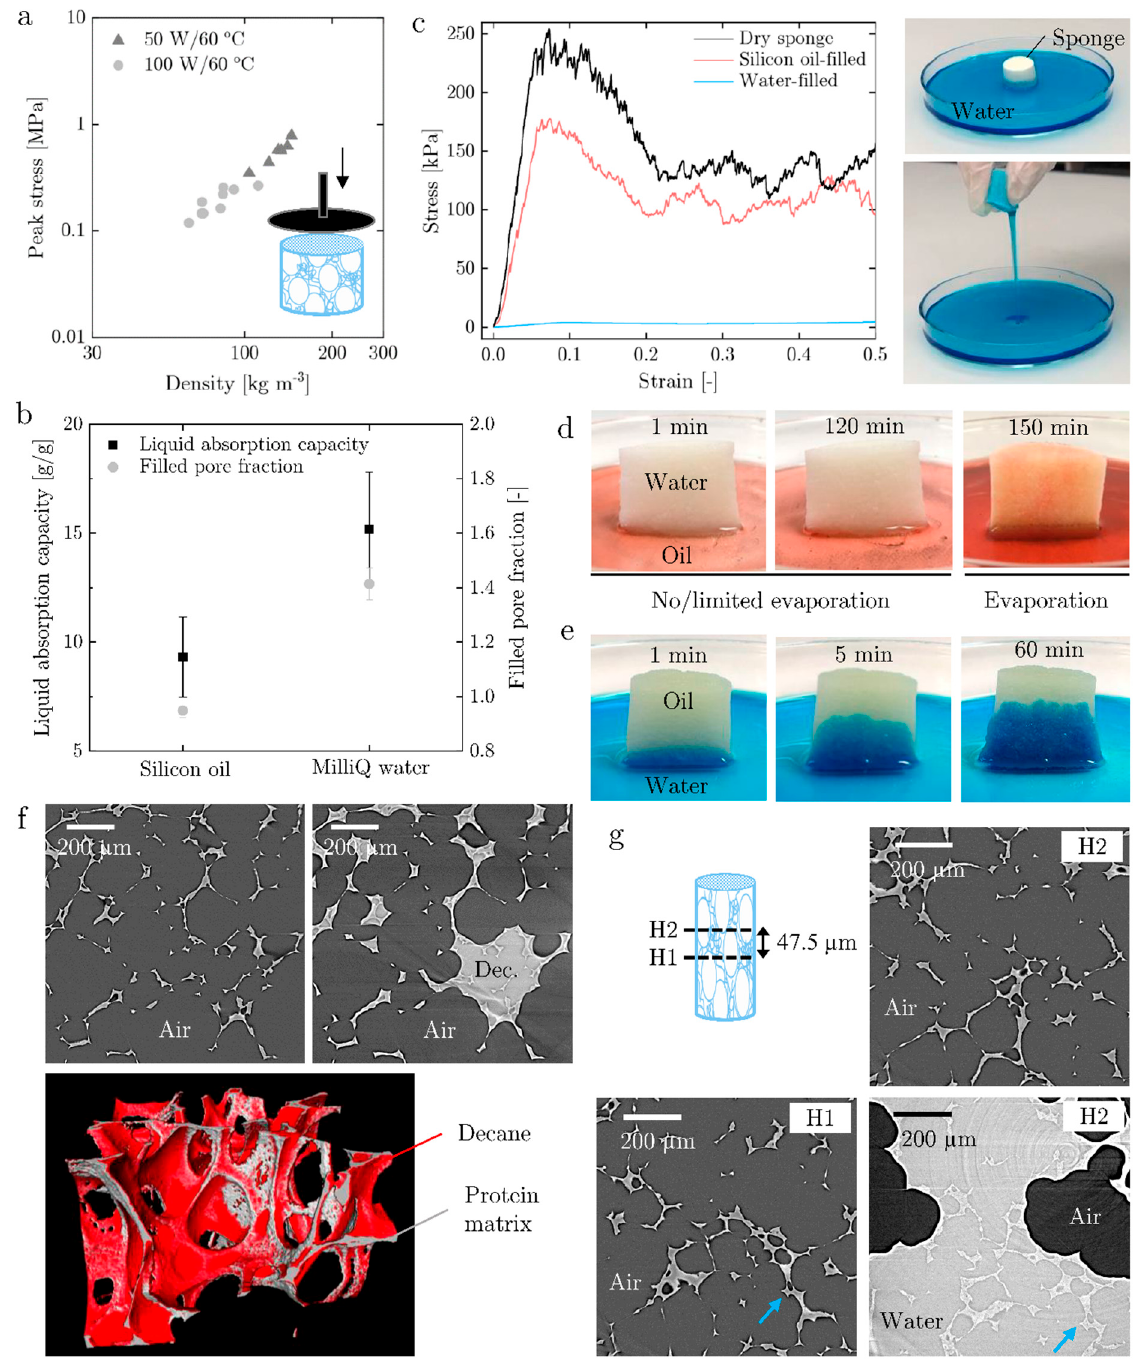
Figure 3. Mechanical properties and liquid absorption of microwave-convection dried protein sponges: ( a ) peak stress in uniaxial compression as function of sponge density; ( b ) liquid absorption capacity and fraction of filled pore volume with silicon oil and MilliQ water for sponges dried at 100 W/60 °C; ( c ) stress response of a sponge dried at 100 W/60 °C in dry state, filled with low-viscous silicon oil, and filled with water in uniaxial compression (left), and images of water absorption and water release by compression (right); ( d ) silicon oil absorption into water-filled 100 W/60 °C sponge with and without limitation of water evaporation (oil stained in red); ( e ) water diffusion and absorption into silicon oil-filled 100 W/60 °C sponge over time (water stained with blue food colorant); ( f ) μ -CT images of 100 W/60 °C sponge in dry state and wetted by decane at the same position (top) and a volume-representation of the binarized μ -CT data, superimposing the volume occupied by decane colored in red with the protein backbone colored in grey (bottom); ( g ) μ -CT images of 100 W/60 °C sponge in dry state at sample height H2 (top right) and sample height H1 (bottom left) and after absorption of water at sample height H2 (bottom right).